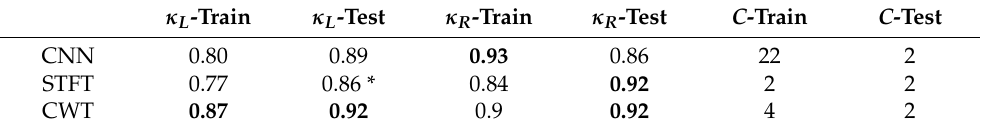
Table 2. Quantitative measures for the sleep–wake dataset. Significantly higher values in a column are in bold (chi-square test); κ indicates the kappa value for SVM; L indicates a linear kernel; R indicates a radial basis function kernel; C indicates the number of clusters by k-means. κ L